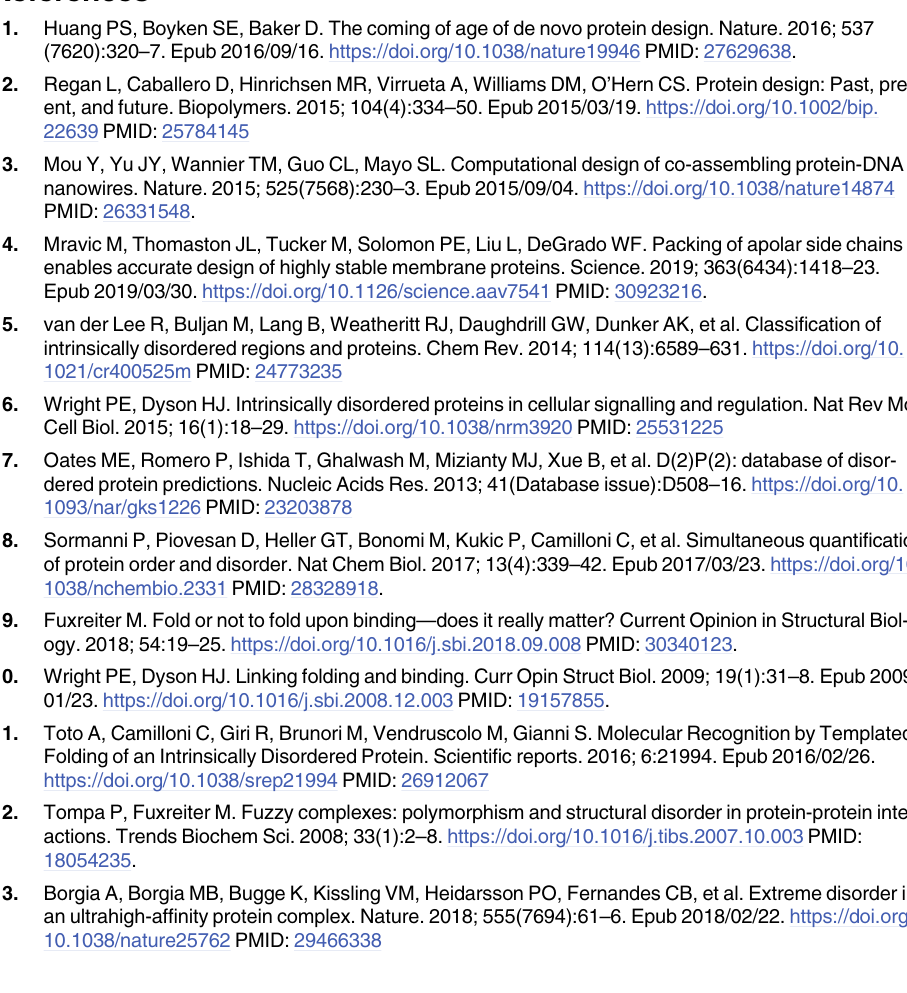
S3 Fig. Predicted binding modes and context-dependence for transient binding sites in the UPF2-UPF1